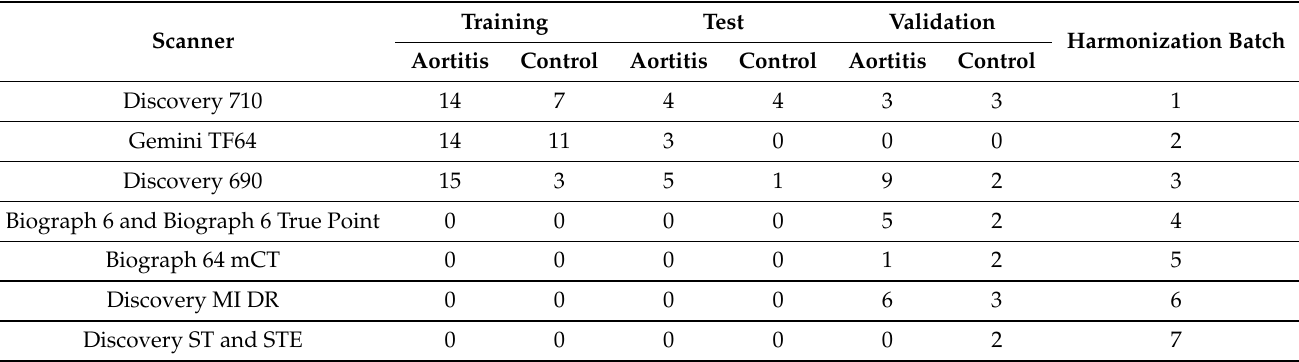
Table 1. Distribution of participants across